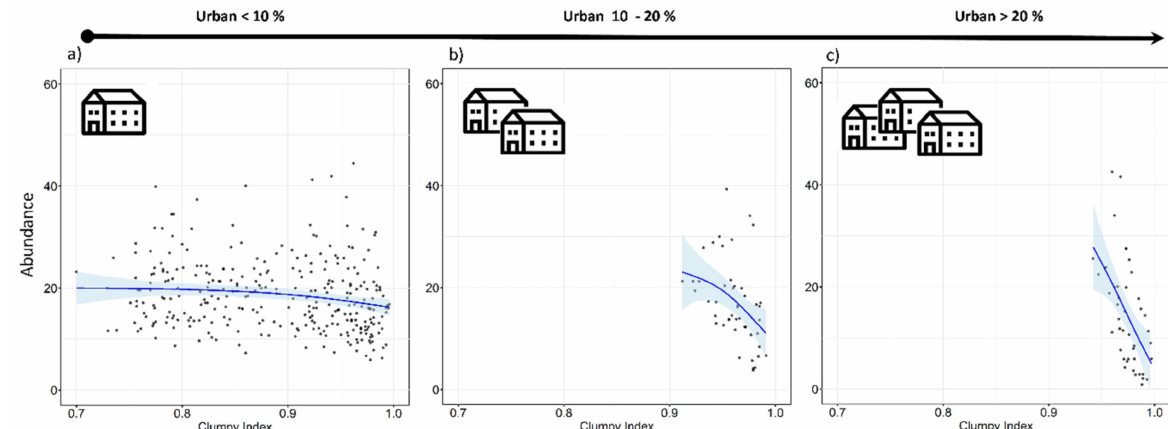
Figure 4. Expected tawny owl ( Strix aluco ) abundance at the local scale and based on the top-ranked model in three levels of urbanization ( a – c ) and at different aggregation levels of the urban patches (clumpiness index). The clumpiness index represents the aggregation level of habitat patches (in our case, urban patches). It is equals to − 1 when the urban patch is maximally disaggregated, 0 when it is randomly distributed, and 1 when maximally aggregated. The blue lines show a cubic smoothing spline fitted to the data in order to show the general trend, while shaded areas show standard error boundaries.